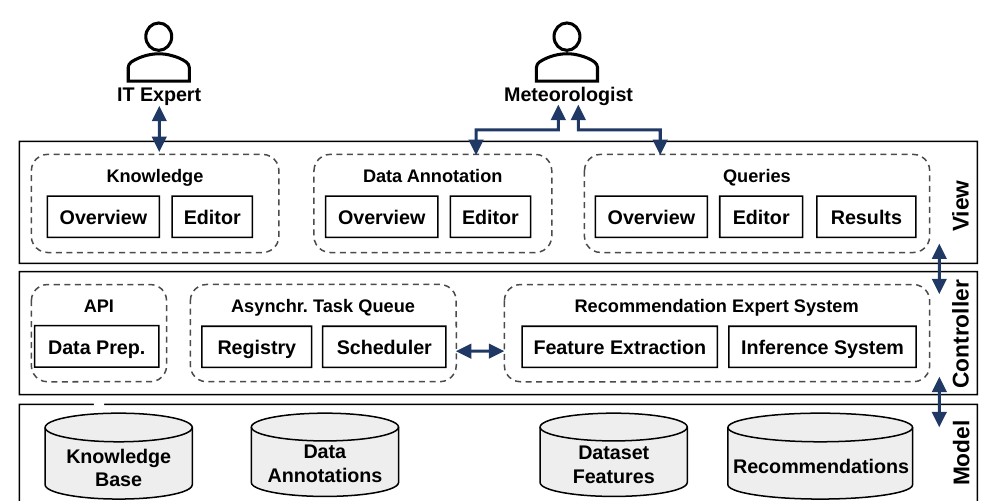
Figure 9. Conceptual architecture of the system.